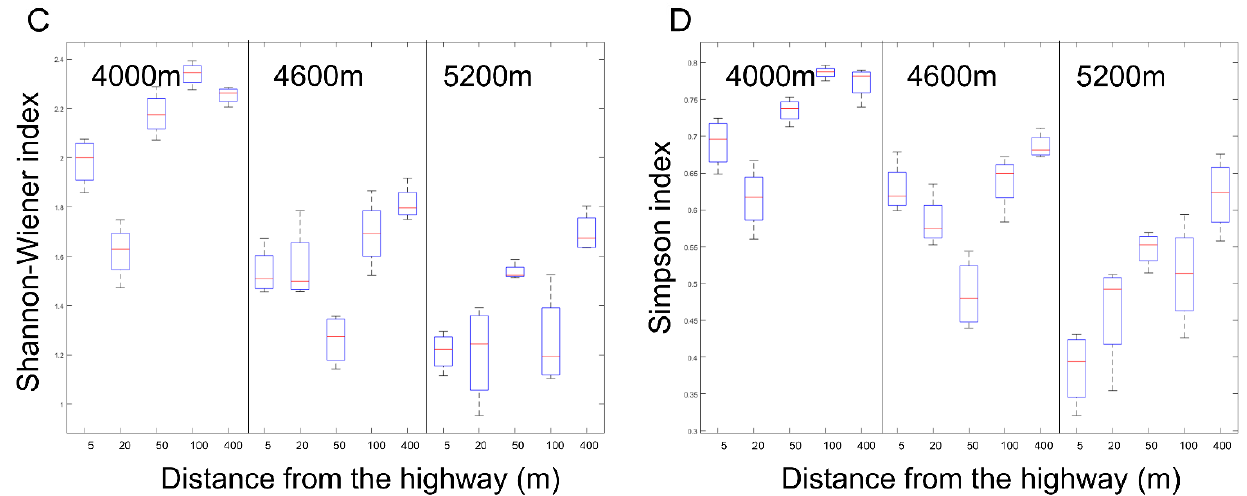
Figure 2. Comparison of ( A ) above-ground biomass, ( B ) plant cover degree, ( C ) plant simpson and ( D ) above-ground biomass between treatments at 5, 20, 50, 100 and 400 m from the curb G109 highways at altitudes of 4000 m (L), 4600 m (M) and 5200 m (H).